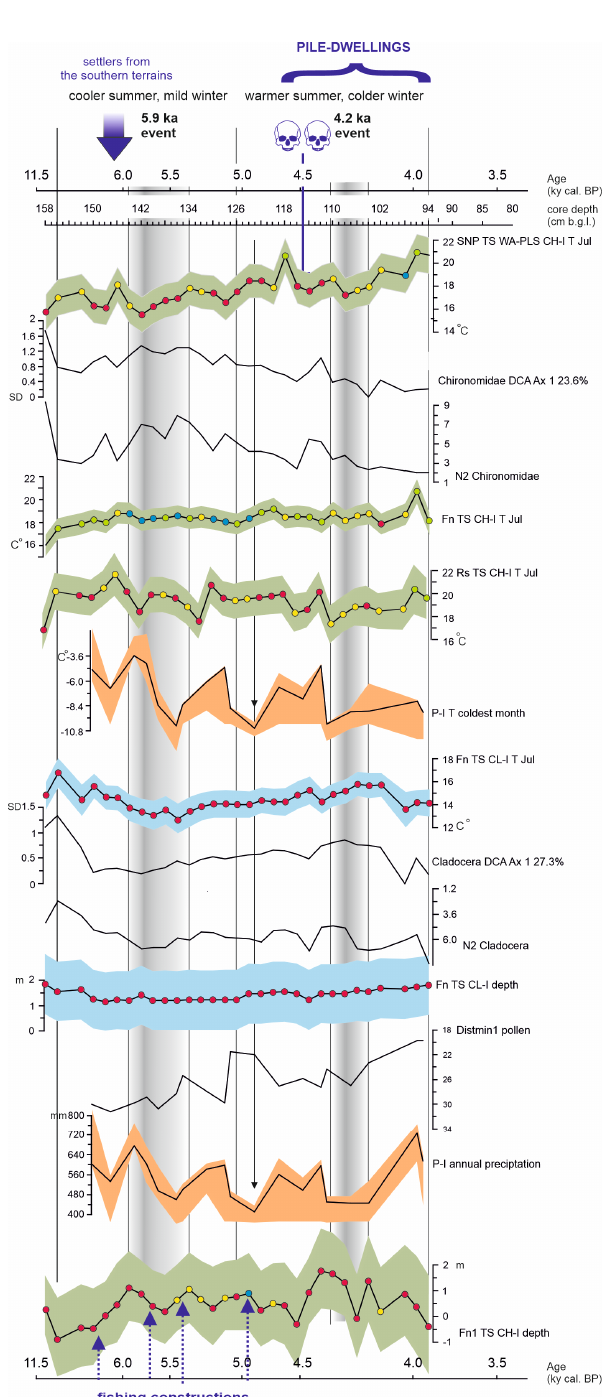
Figure 5. Results of quantitative climatic and water depth reconstructions: SNP TS WA-PLS CH-I T Jul; Chironomidae DCA Ax1 23.6%; N2 Chironomidae (the number of occurrences of Chironomidae species); Fn TS CH-I T Jul; Rs TS CH-I T Jul; P-I TCM; Fn TS CL-I T Jul; Cladocera DCA Ax1 27.3%; N2 Cladocera (the number of occurrences of Cladocera species); Fn TS CL-I depth; Distmin1 pollen (Euclidean distances calculated between the eight modern pollen assemblages considered as the best analogues and the fossil assemblage—nearest and furthest); P-I AnP; and Fn TS CH-I depth. Skulls with an arrow indicate the depth of the skeleton deposition. The arrows at 4.9 ka indicate peaks in precipitation and TCM (i.e., maximum